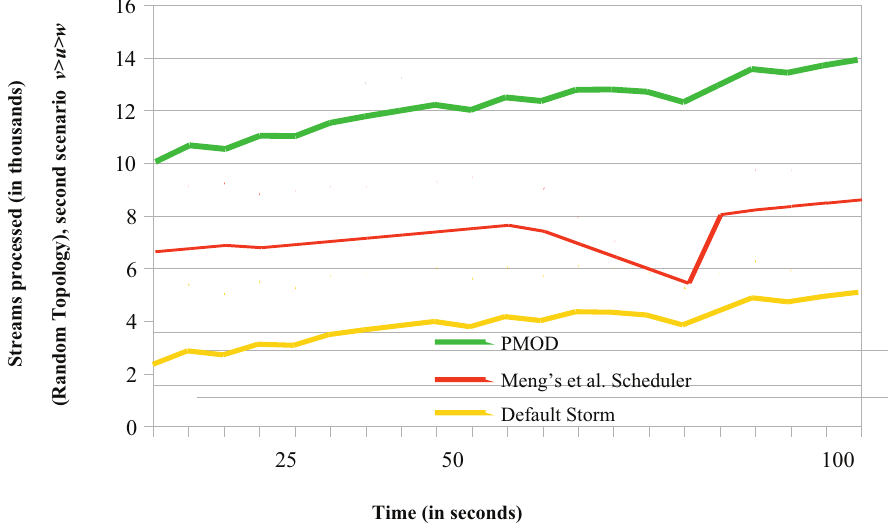
Figure 5. Throughput comparisons with a random topology for the second scenario: ( v > u > w )